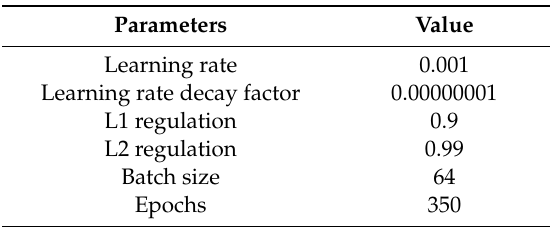
Table 2. Parameter